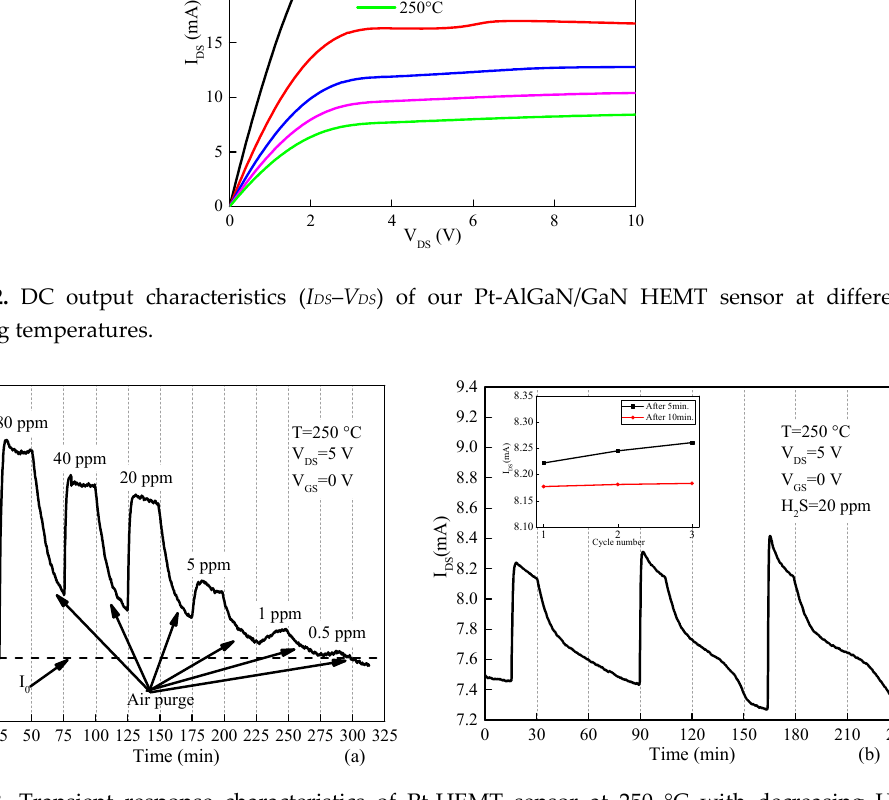
Figure 3. Transient response characteristics of Pt-HEMT sensor at 250 °C with decreasing H 2 S concentration from 80 ppm to 0.5 ppm ( a ) and signal repeatability for 20 ppm H 2 S concentration ( b